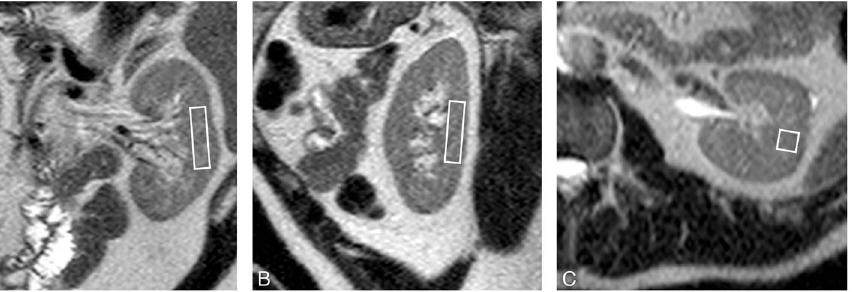
Figure 1. Planning of the proton magnetic resonance spectroscopy voxel. Placement of the proton magnetic resonance spectroscopy ( 1 H- MRS) voxel (40 6 10 6 10 mm), avoiding contamination with intra-abdominal/perirenal and renal sinus fat. Coronal (A), sagittal (B) and transverse (C) scout images (single shot turbo spin echo).